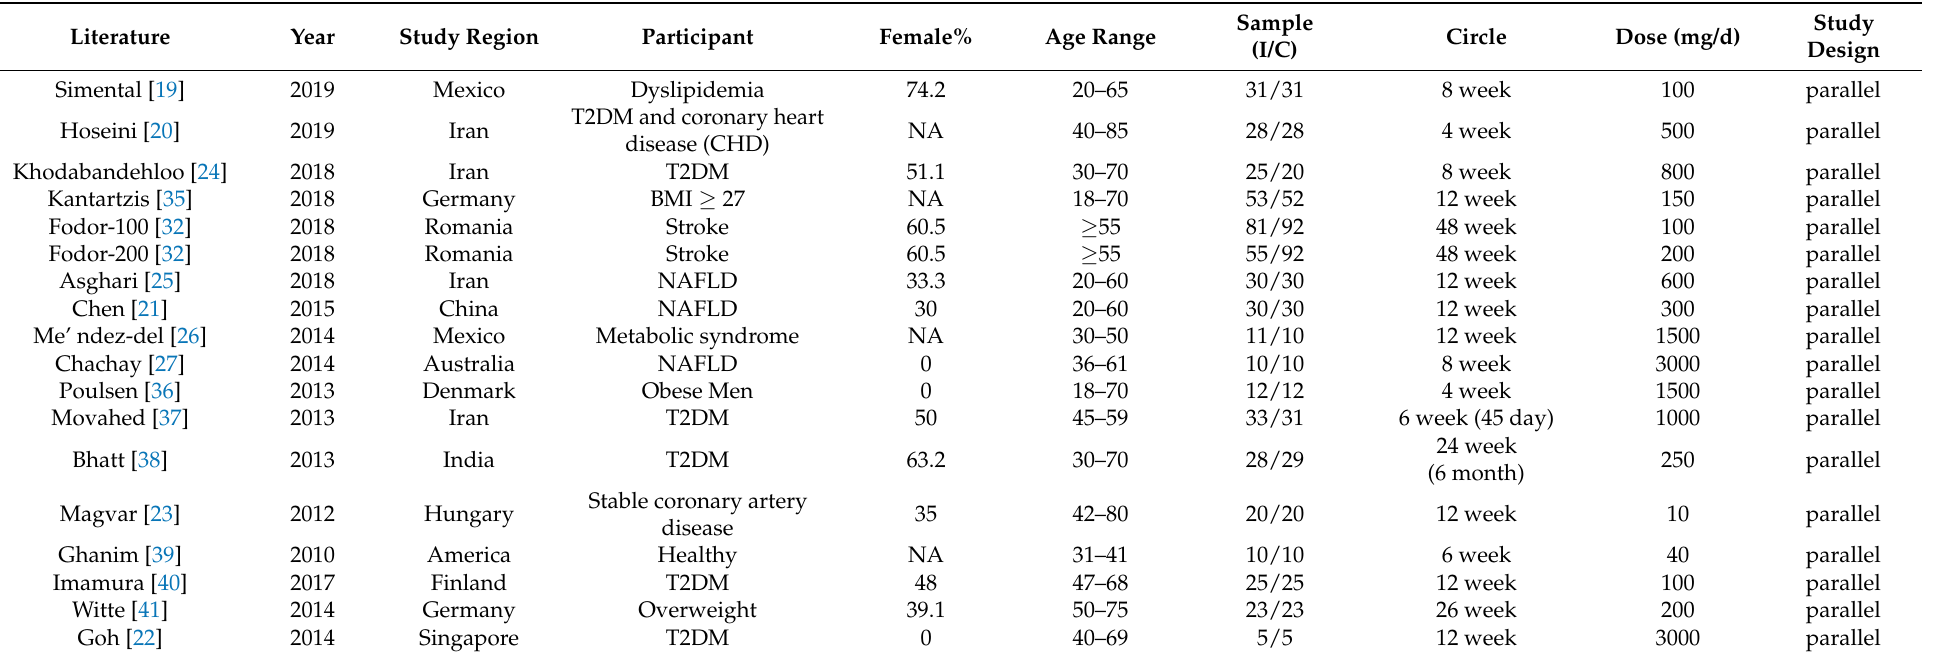
Table 1. Characteristics of the studies